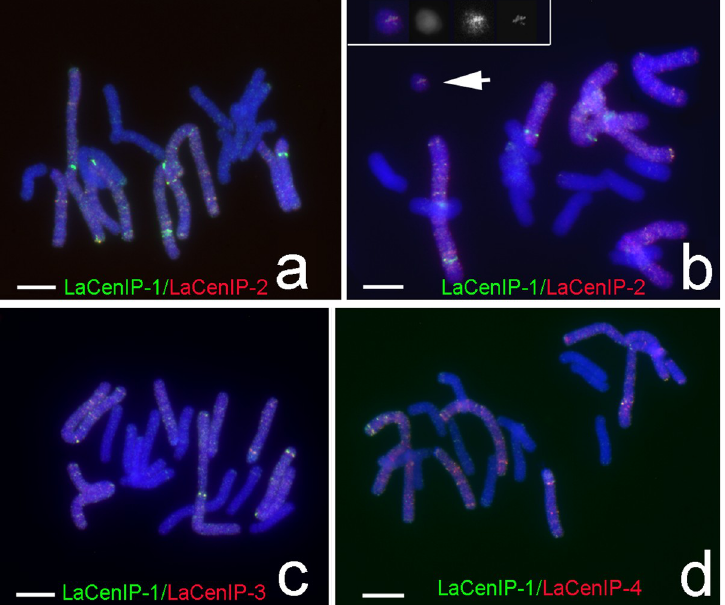
other probes (Figs 10 and 11). Furthermore, FISH with the LaCenIP-1 and LaCenIP-1R-E1